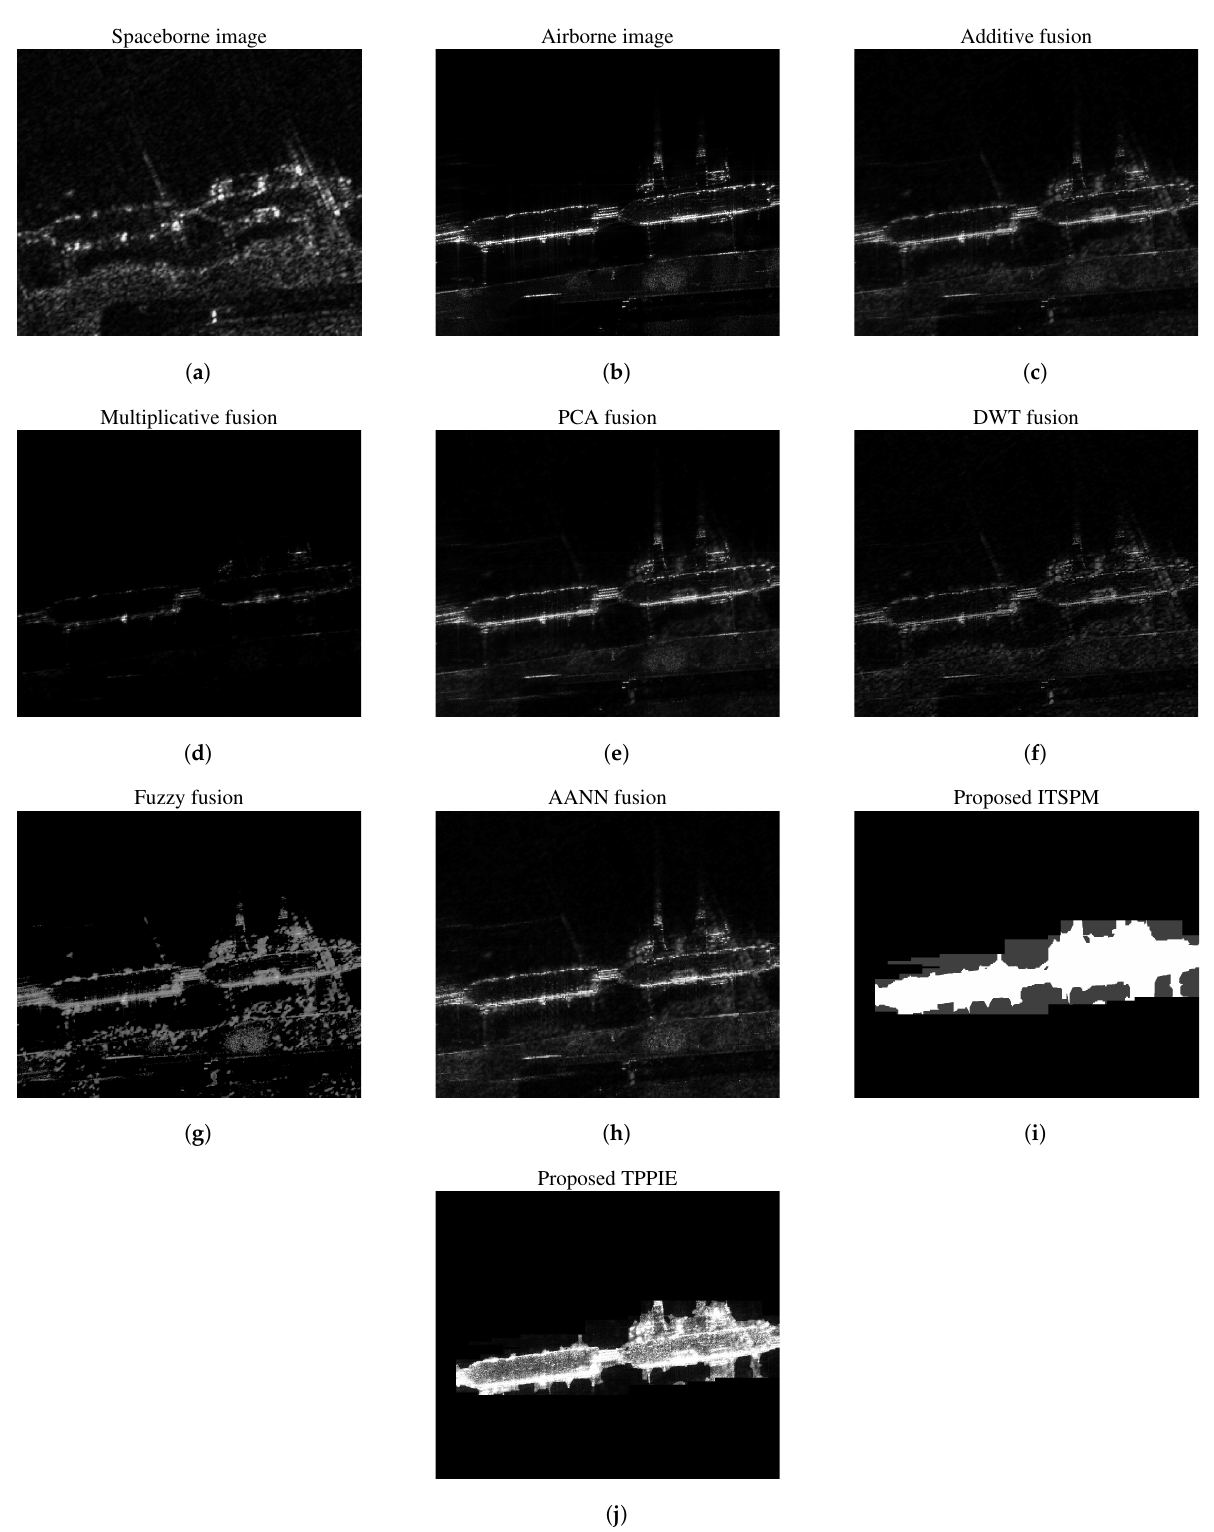
Figure 7. Experimental results for scene 2: ( a ) Spaceborne image; ( b ) airborne image; ( c ) additive fusion [10]; ( d ) multiplica- tive fusion [10]; ( e ) PCA fusion [12]; ( f ) DWT fusion [13]; ( g ) fuzzy fusion [16]; ( h ) AANN fusion [18]; ( i ) proposed ITSPM fusion; and ( j ) proposed TPPIE fusion. The proposed methods can achieve better fused images with enhanced target regions and suppressed background regions, compared to the other image fusion